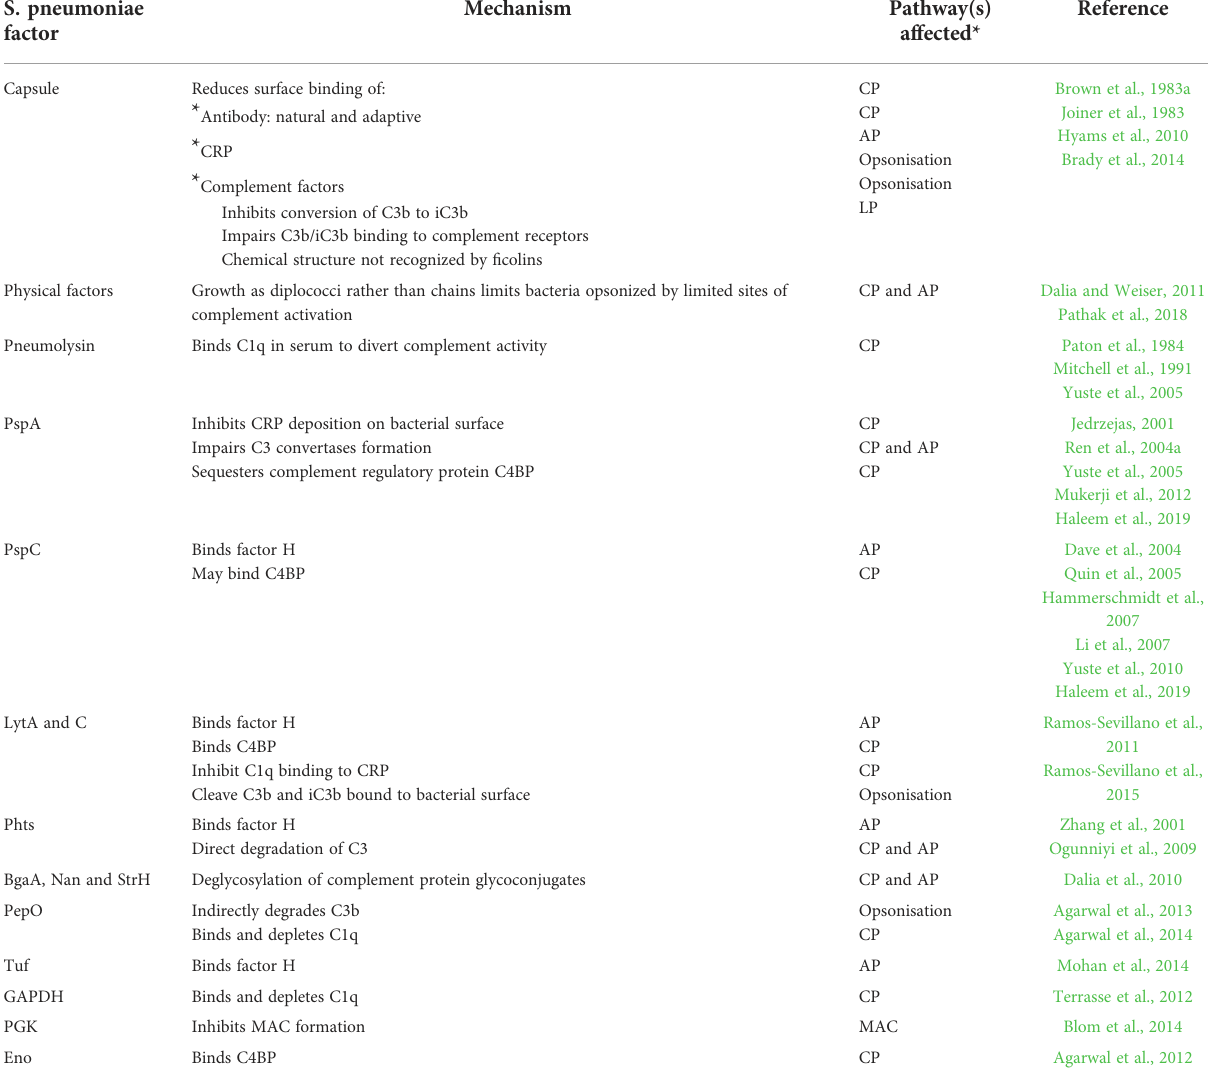
TABLE 1 Mechanisms of inhibition of complement activity by S.